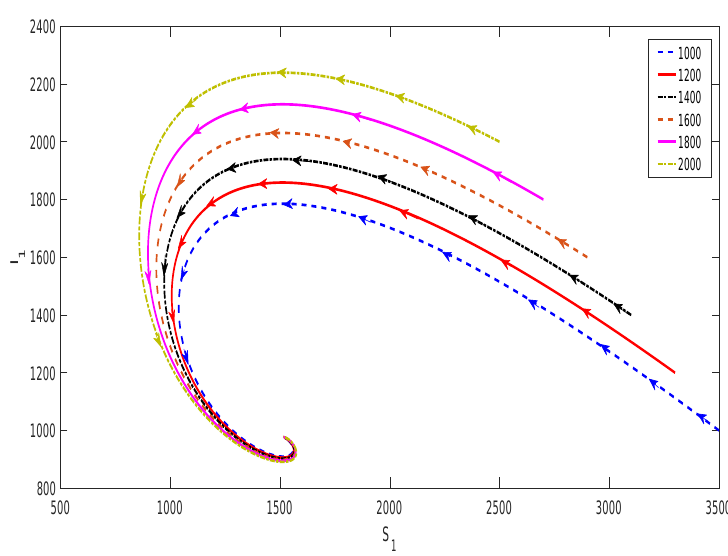
Figure A1. Phase portrait illustrating the global stability of E ∗ for the system in Equation (1) in the S 1 - I 1 plane with R 0 = 2.84 (we set β 1 = β 2 = 1.5). Each curve in the plot corresponds to a different initial condition, and all these curves converge to the equilibrium E ∗ (where S 1 = S 2 over